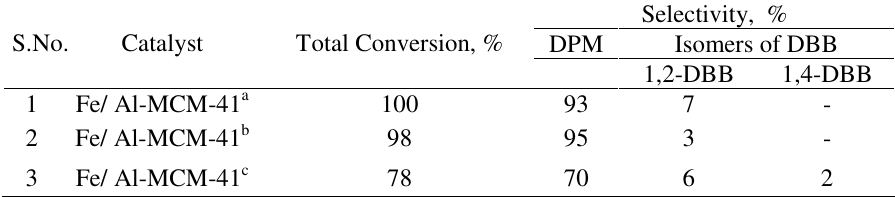
Table 1 . Catalytic activity of various catalysts in the benzylation of benzene with benzylchloride